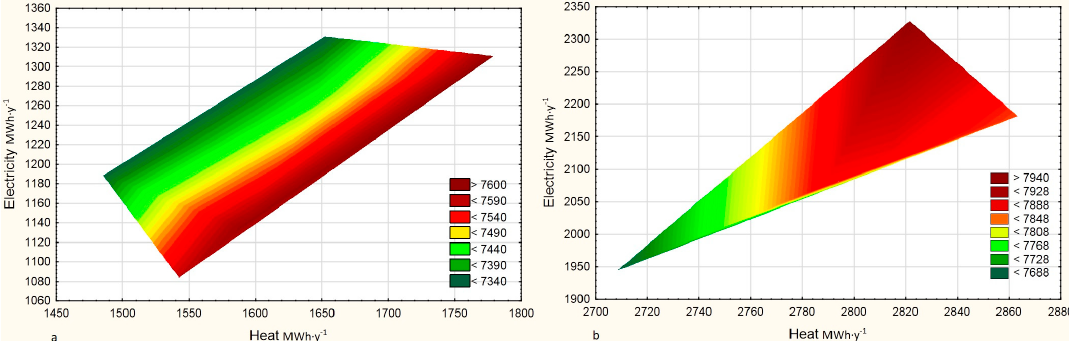
Figure 4. Energy production depending on CHP running time: ( a ) before optimisation, 2012–2017; ( b ) after the introduction of plant operation management, 2018–2022.